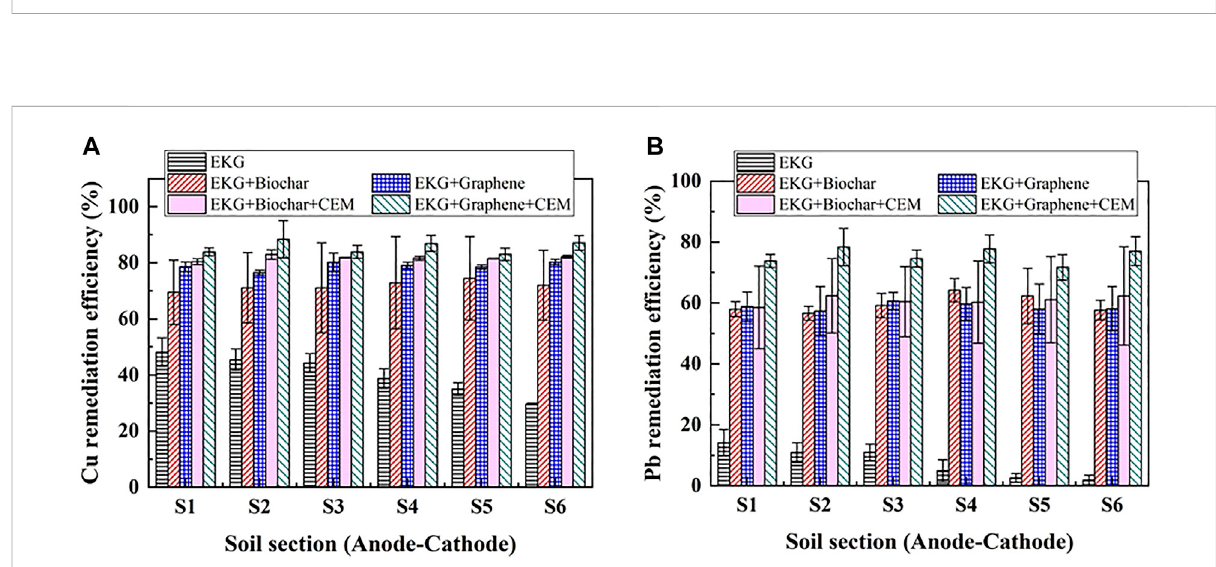
FIGURE 11 Removal of Cu and Pb after the electrokinetic experiment subjected to the effect of the different treatments: (A) Cu and (B)